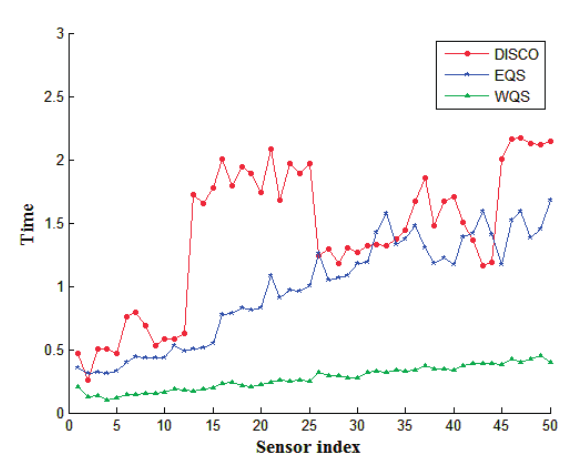
Figure 8. The average duty cycle time on different device densities.